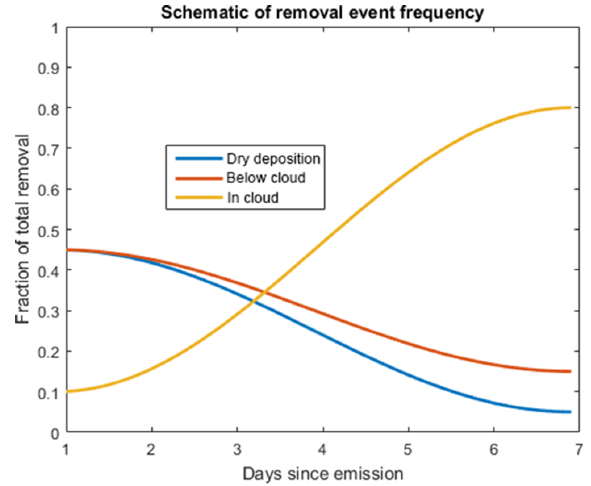
Figure 4. Relative frequency of removal events for a pulse of dust emitted in Central Europe on 14 April 2007. For illustration pur- poses, daily frequencies were fitted with a